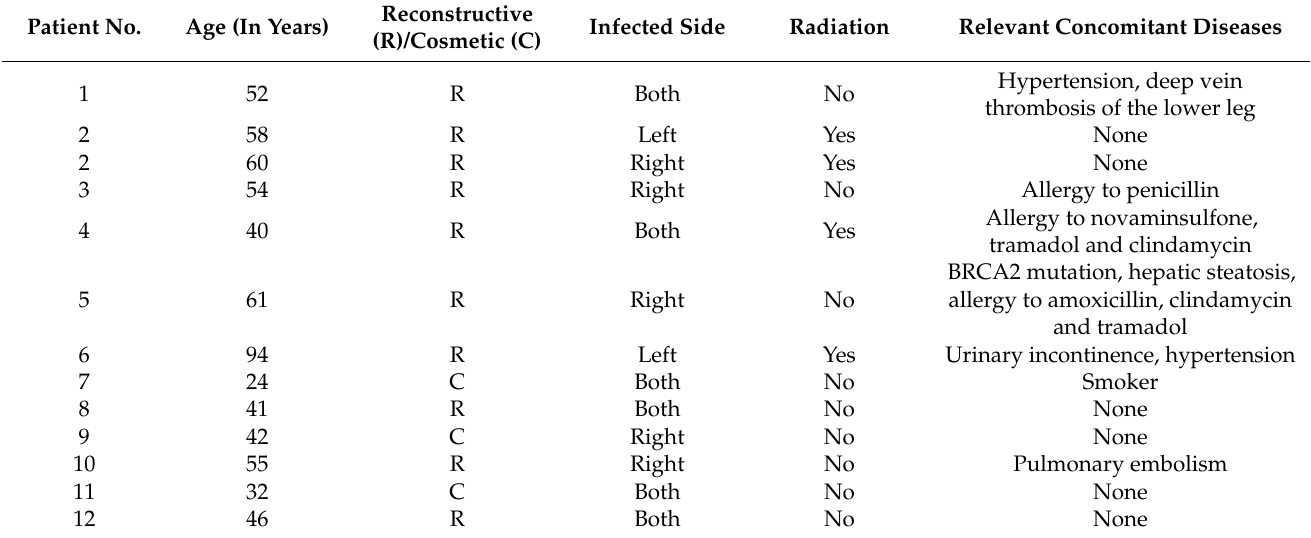
Table 1. Patient characteristics.